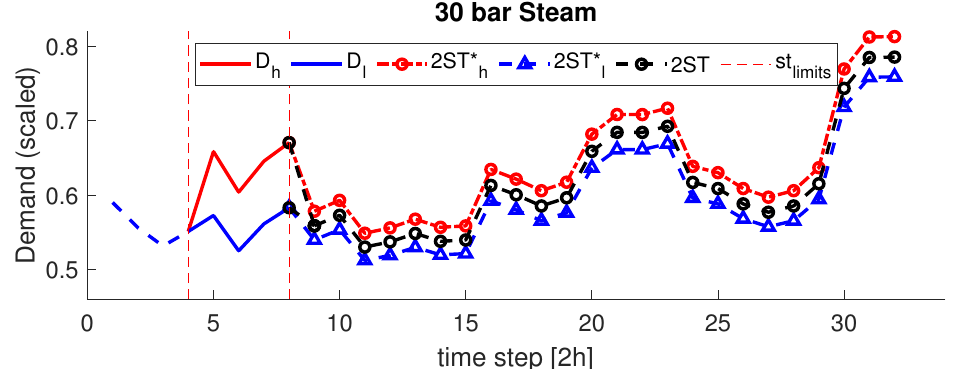
Figure 13. An example of the calculated steam demand trajectories of the second-stage based on the 2ST ∗ and 2ST approaches for the 30 bar steam network for two different demand regions in the first-stage.